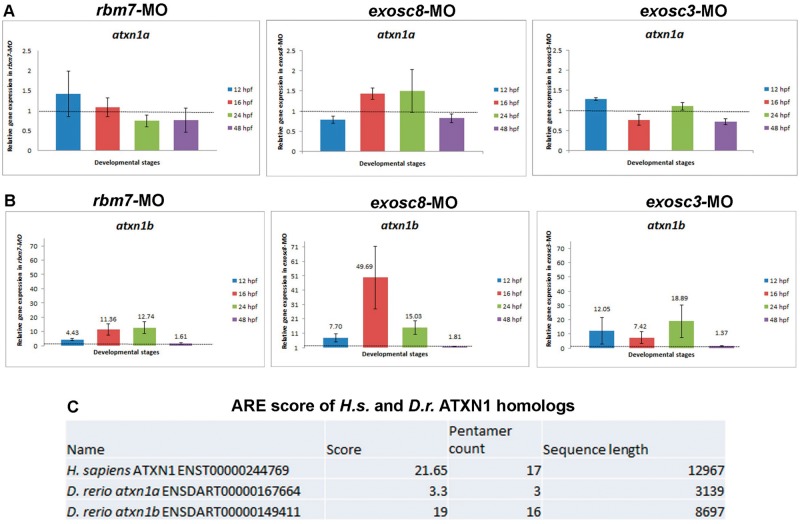
Gene expression analysis of atxn1a and atxn1b in zebrafish upon knock down of rbm7, exosc8 and exosc3. Knock down of all three genes did not affect expression of atxn1a
(A) while expression of atxn1b was greatly affected by defective functionality of the exosome complex (B). Error bars indicate SD qRT-PCR analysis repeated three times on different biological samples. Gene expression data are in agreement with the AU-content of atxn1a and atxn1b
(C). Human ATXN1 has an AU-content similar to zebrafish atxn1b.